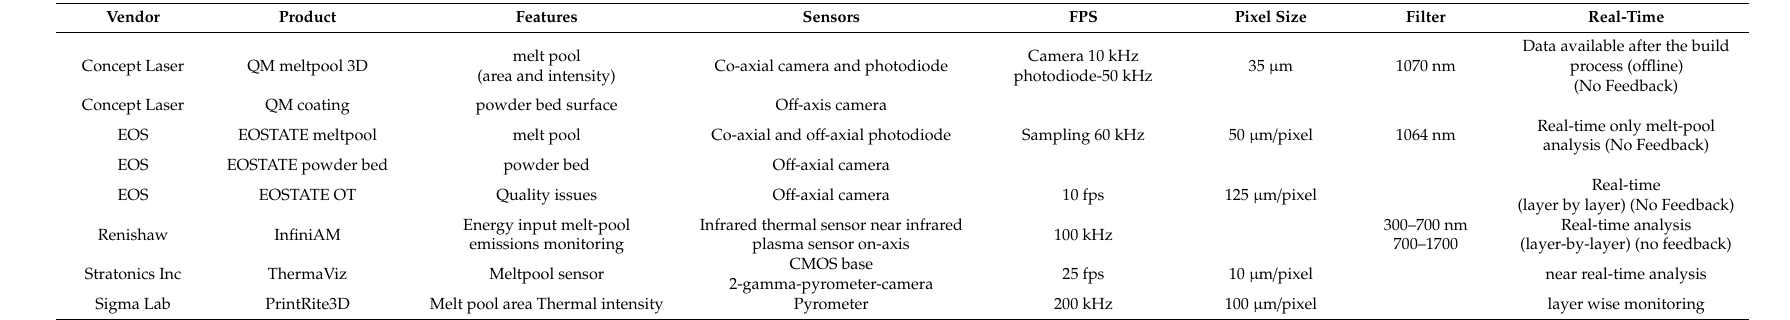
Table A1. Commercial monitoring